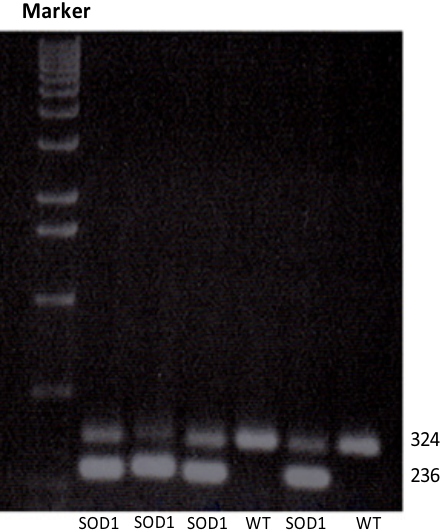
FIGURE 1 – Procedure of genotyping in order to determine the fenotype, mutant and wild-type to the enzime human superoxid dismutasis 1 (SOD1).In the mutant mice B6SJL-TgN(SOD1-G93A)1 Gur (SOD1) two bands can be observed, the mutant one (236 pb) and the wild-type one (324 pb).